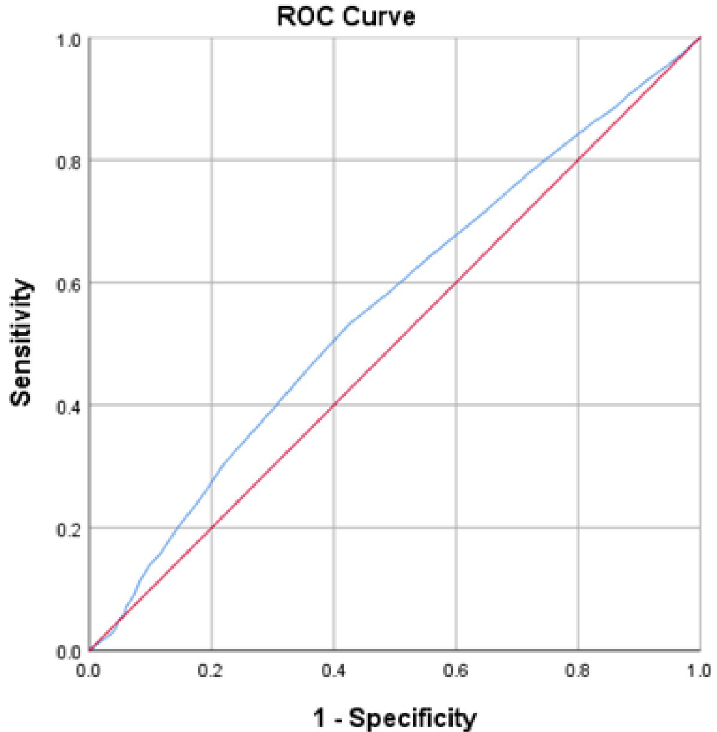
Fig 2. ROC curve of FCV-19S for